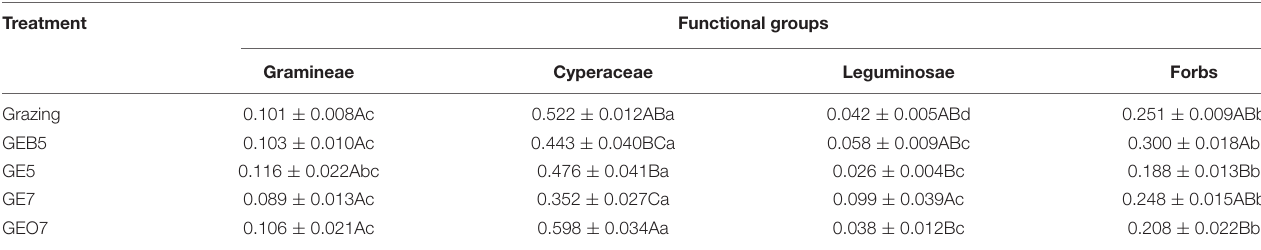
TABLE 3 | The importance value of Gramineae, Cyperaceae, Leguminosae, and forbs among the grazing exclusion gradient. Treatment